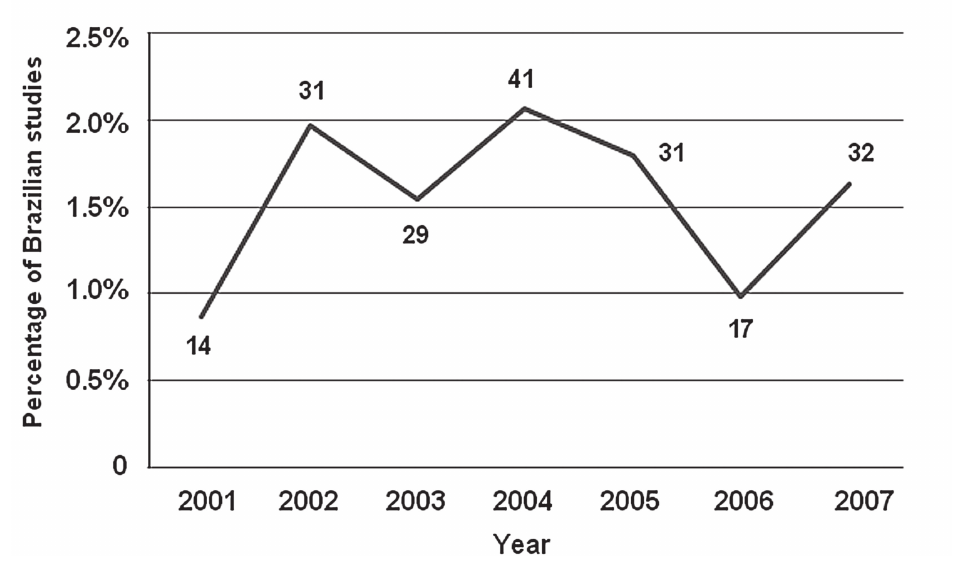
Figure 1 - Absolute numbers (shown inside the graph) and percentages (Y-axis) of Brazilian studies presented at the American Urological Association in years 2001 through 2007 (P for